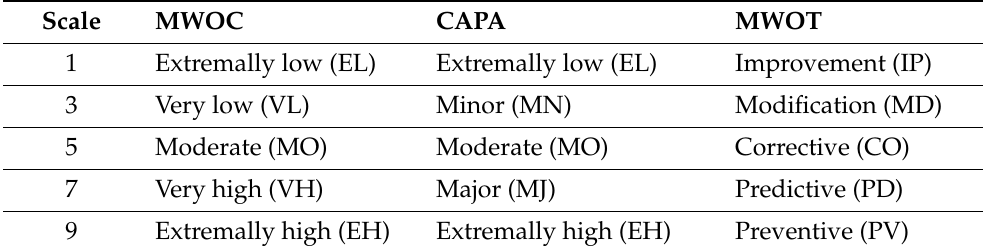
Table 8. Conversion scale for qualitative evaluation of criteria performance.